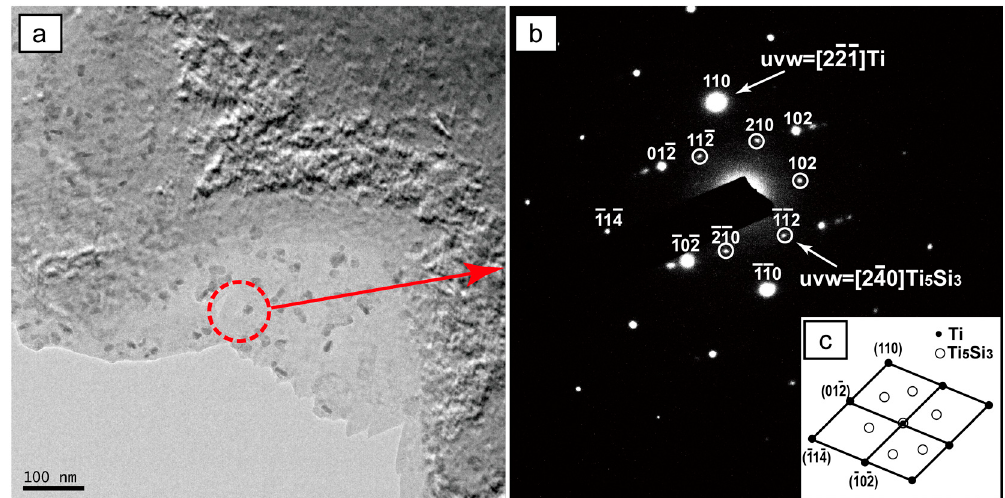
Figure 8. The TEM images and selected area electron diffraction (SAED) of TMCs refined and reinforced by in situ Ti 5 Si 3 /Ti composite ribbon inoculants: ( a ) TEM image of TMCS; ( b ) SAED in the zone A in Figure 8a; ( c ) the structure model of diffraction spots.